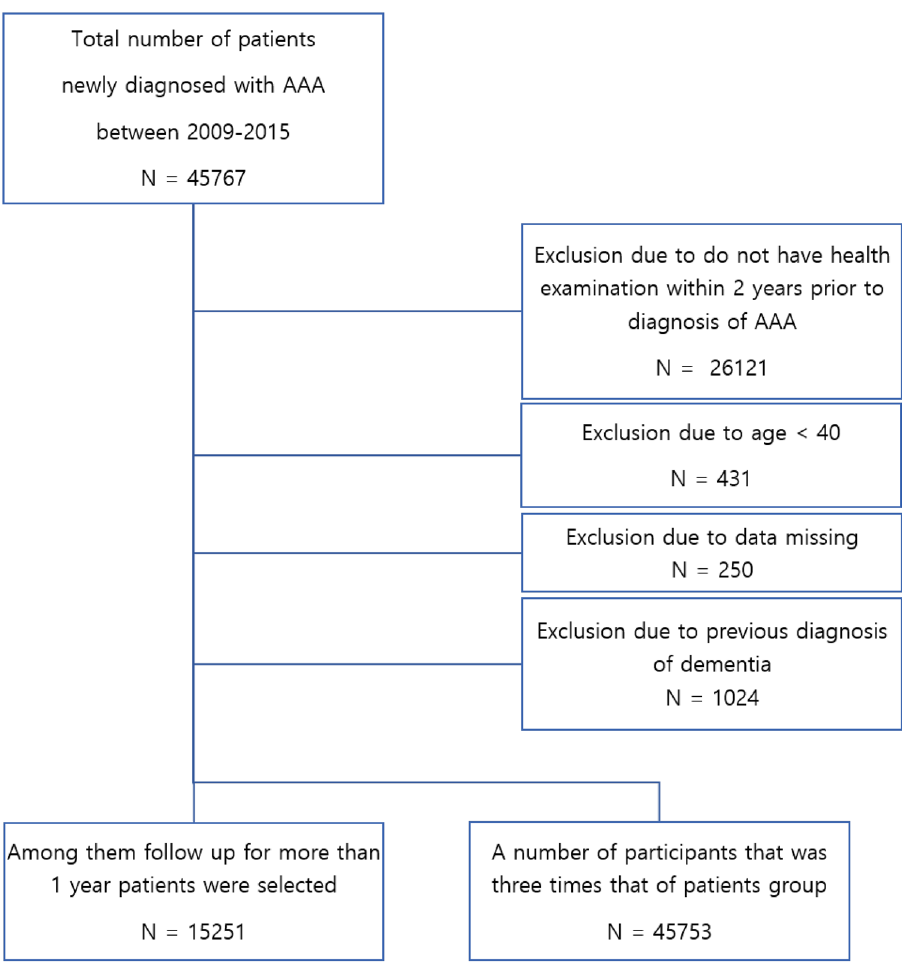
Figure 1. Enrollment flow